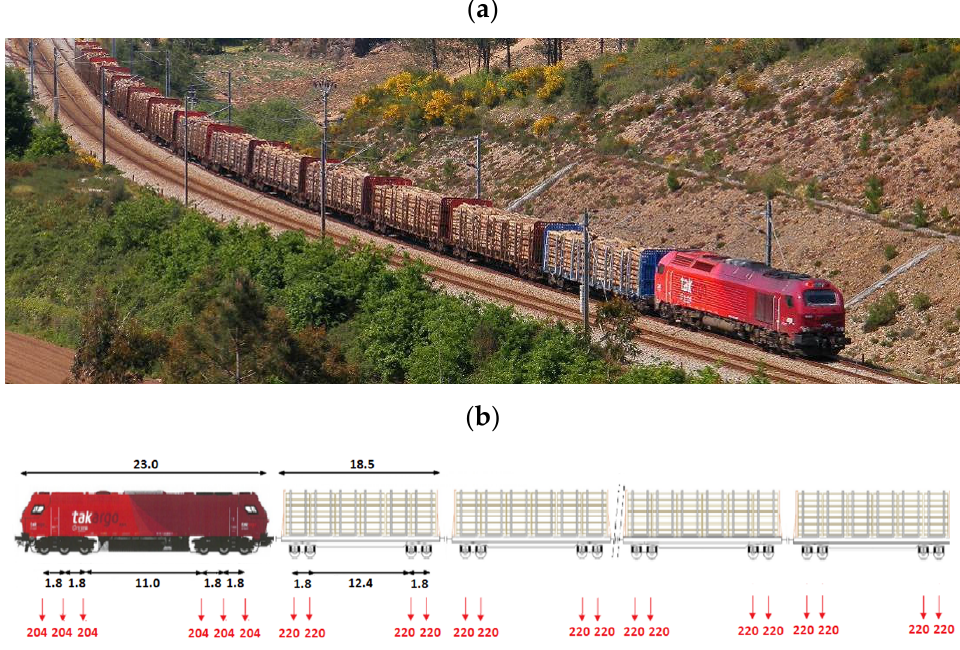
Figure 1. Freight train locomotive EURO 4000 with Sgnss type wagon: ( a ) general overview; ( b ) loading scheme (distances in metres and loads in kN).